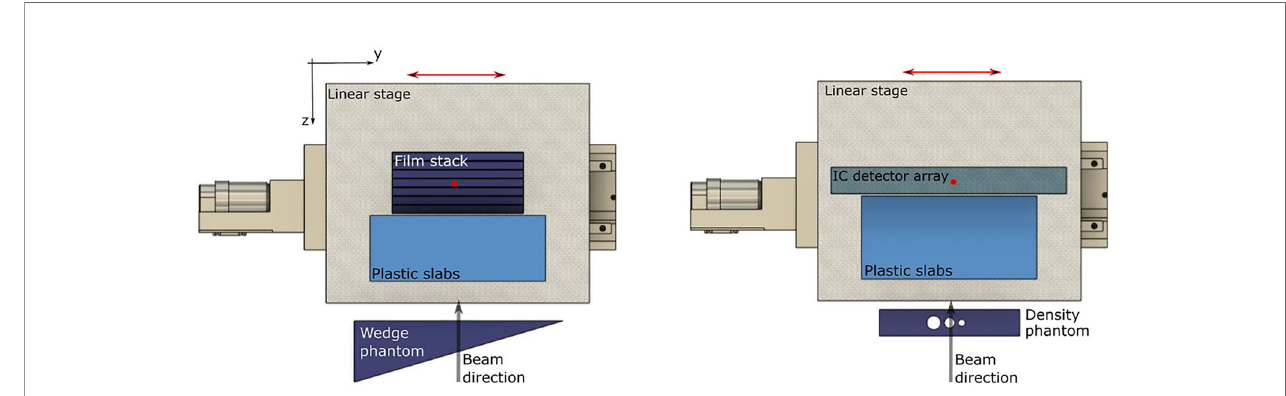
FIGURE 1 | Setups for testing motion compensation through heterogenous targets. A combination of four setups were used with either the wedge or density phantom and where measurements were made with either an IC array detector or fi lm stack. A top view of the wedge-shaped phantom (left) and slab phantom with density heterogeneities (right) are shown, placed in front of a periodically moving linear stage. For all setups, the dosimeter was placed behind a set of plastic slabs. Isocenter is marked with a red circle and the linear stage movement is indicated with a red